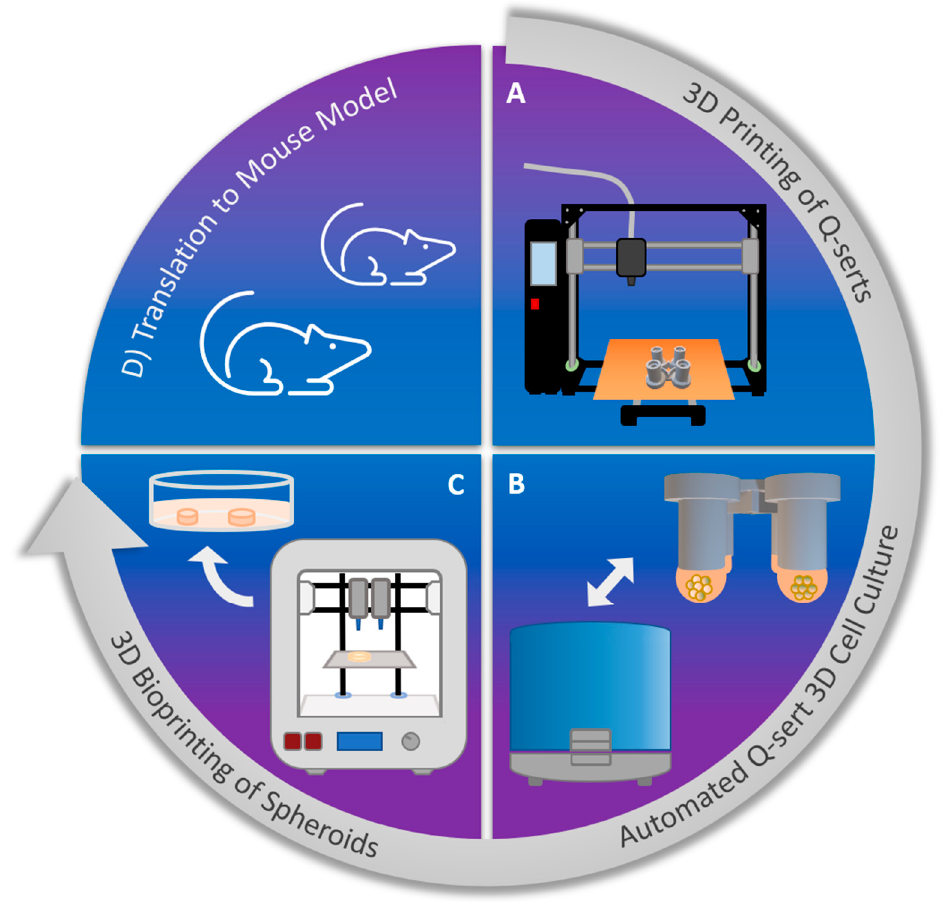
Figure 1. Workflow of the next generation of translational cancer research: ( A ) 3DP of devices for 3DCC using a readily available biocompatible polymer using a fused filament deposition (FFD) printer. ( B ) Culturing of cancer cells using hanging drop method in 3D printed devices (Q-serts), media change and transfer of spheroid using a standard pipetting robot. ( C ) 3DBP of spheroids using a common 3D bioprinter and a hydrogel bioink mimicking TME. ( D ) Extrapolation of findings from bioprinted spheroids’ cultures into rodent models and implantation of 3D printed spheroids into rodents.